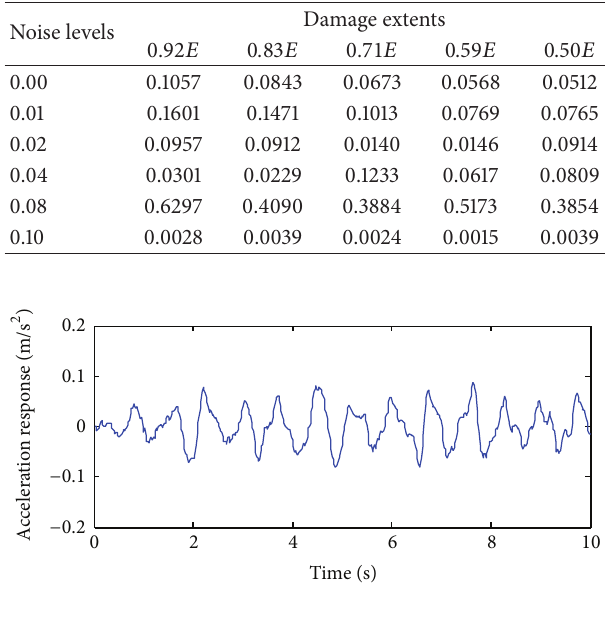
Figure 14: The time series of the accelerometer without noise.